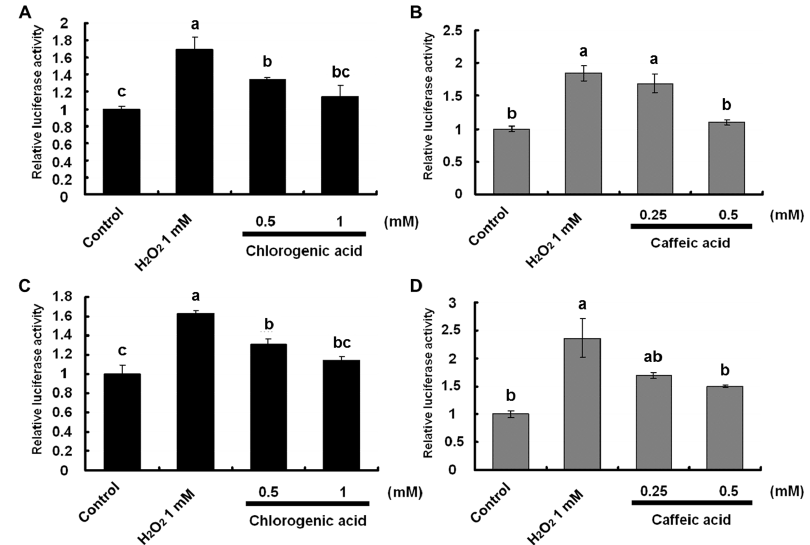
Figure 2. Inhibitory effect of chlorogenic acid (CHA) and caffeic acid (CA) on hydrogen peroxide (H 2 O 2 )-induced interleukin (IL)-8 and nuclear factor kappa-light-chain-enhancer of activated B cells (NF- κ B)-dependent transcriptional activities in Caco-2 cells. ( A , B ) Undifferentiated Caco-2 cells were co-transfected with the pGL-3 basic vector containing IL-8 promoter region ( C/EBP , AP-1 , and NF- κ B ) and pRL-CMV control vector; ( C , D ) Undifferentiated Caco-2 cells were co-transfected with the pGL-3 promoter vector containing four binding sites (5 (cid:48) -TGGAATTTCCTCT-3 (cid:48) ) of NF- κ B and pRL-CMV control vector; ( A , C ) Cells were also treated with 1 mM H 2 O 2 and 0.5–1 mM CHA; and ( B , D ) 0.25–0.5-mM CA for 24 h. IL-8 and NF- κ B transcriptional activities were estimated using a luciferase assay. Values are mean ± SE ( n = 3). Means that have no letter in common are significantly different from each other ( p < 0.05) by Tukey’s